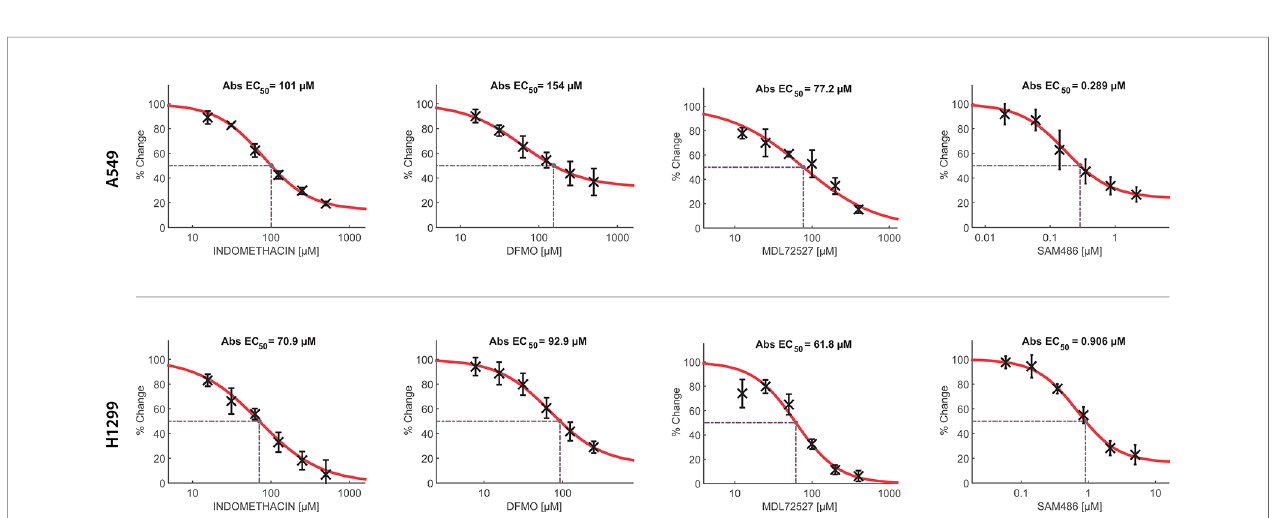
FIGURE 4 | Measurement of the levels of polyamine-related enzymes in non-small cell lung cancer (NSCLC) cells. The levels of four polyamine-related enzymes: ornithine decarboxylase (ODC), adenosyl-methionine decarboxylase (AMD1), polyamine-oxidase (PAOX), and spermine oxidase (SMOX) were evaluated using western blotting in two NSCLC cell lines (A549 and H1299) and one normal epithelial lung cell line (BEAS-2B). The levels of vinculin were used as internal control. (A) Representative blots of vinculin, ODC, AMD1, PAOX, and SMOX in the BEAS-2B, A549, and H1299 cells. (B) Quantitation of ODC, AMD1, PAOX, and SMOX levels in the three cell lines. Protein levels are expressed as the ratio of protein/vinculin in each sample. The graph summarizes fi ve independent measurements. * p < 0.05 and *** p < 0.001, compared with BEAS-2B cells, calculated using one-way ANOVA. (C) Schematic view showing the role of each polyamine pathway enzyme. The panel also shows the best-known inhibitors of ODC [e fl ornithine, (DFMO)], AMD1 (SAM486), and PAOX/SMOX (MDL72527).